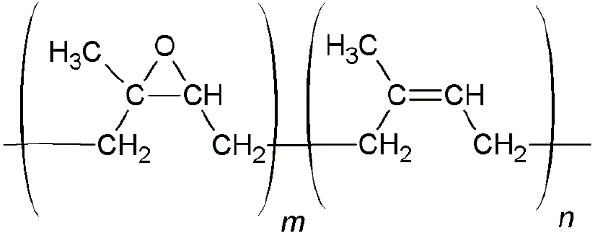
Figure 9. Chemical structure of epoxidized natural rubber (ENR ‐ 50).